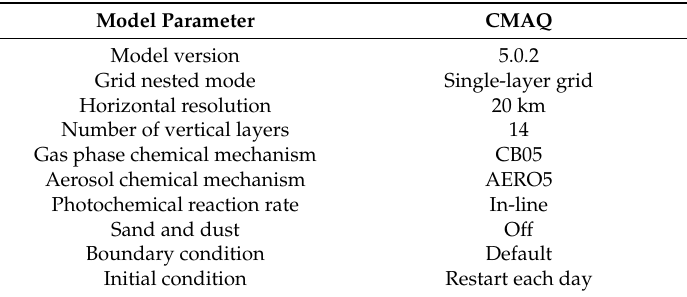
Table 4. CMAQ model parameterization